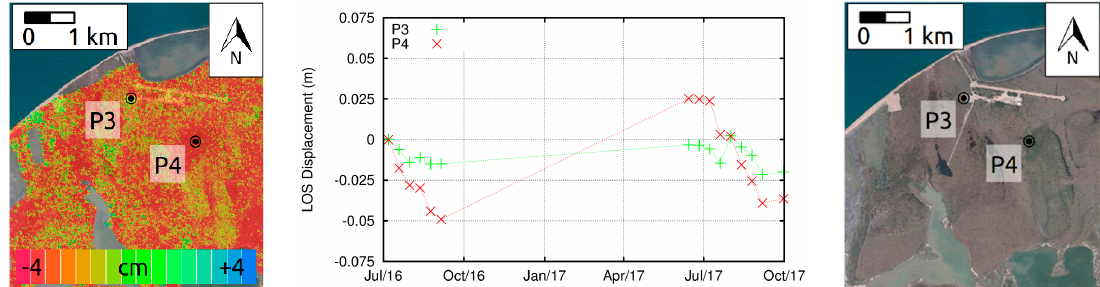
Figure 4. Time series of displacement in the line ‐ of ‐ sight direction over former fuel tanks close to the abandoned airfield at Point Lonely (P3) and in Arctic peaty sandy lowlands (P4) within the Teshekpuk Lake site. For location see Figure 2. Map data are from Google, DigitalGlobe.